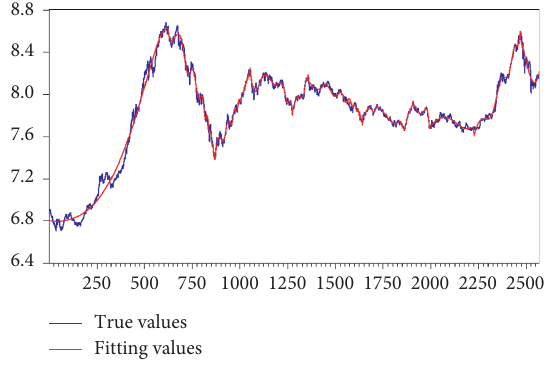
Figure 20: Fitting results from 2005/4 to